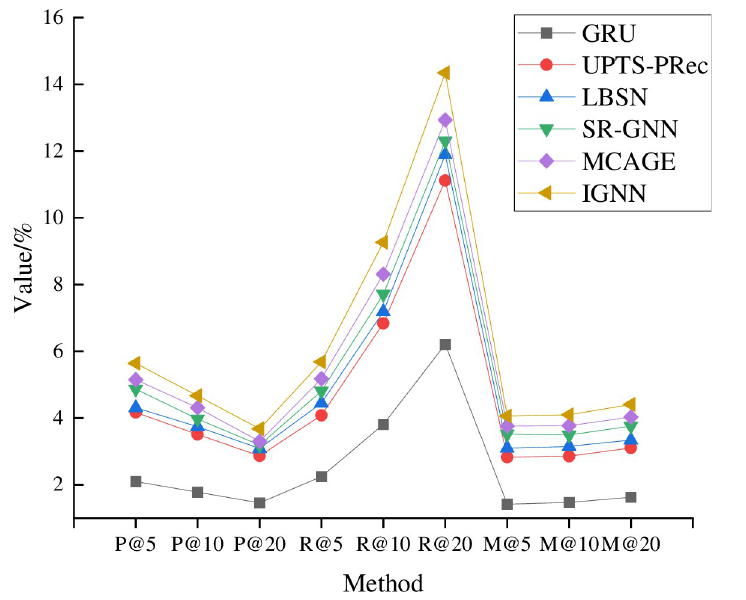
Fig 7. Model training results on Yelp